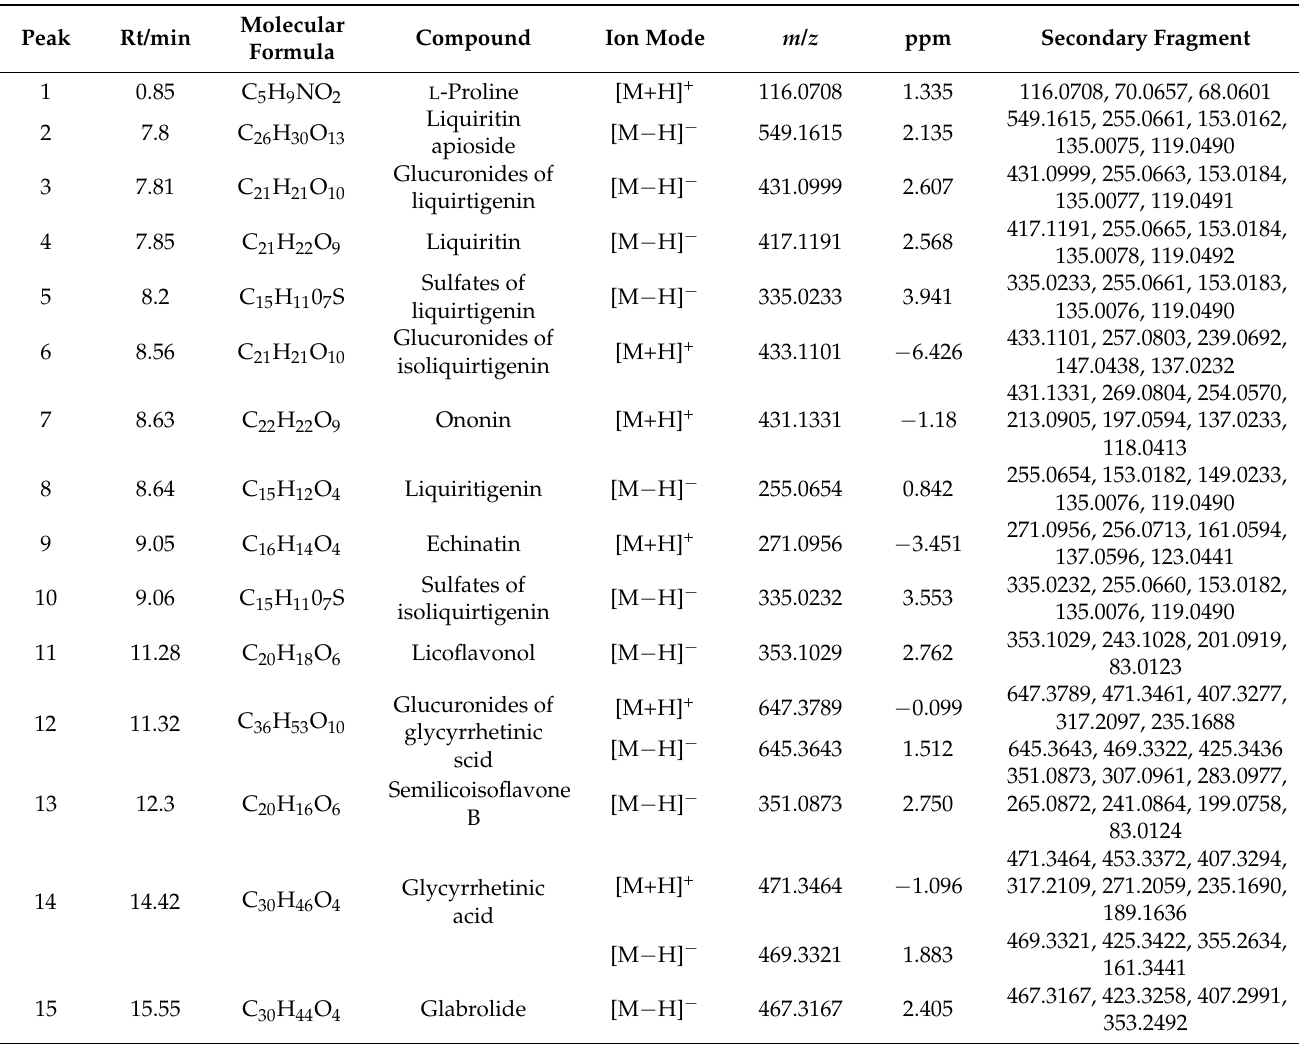
Table 1. Identification results of components of roasted licorice in rat